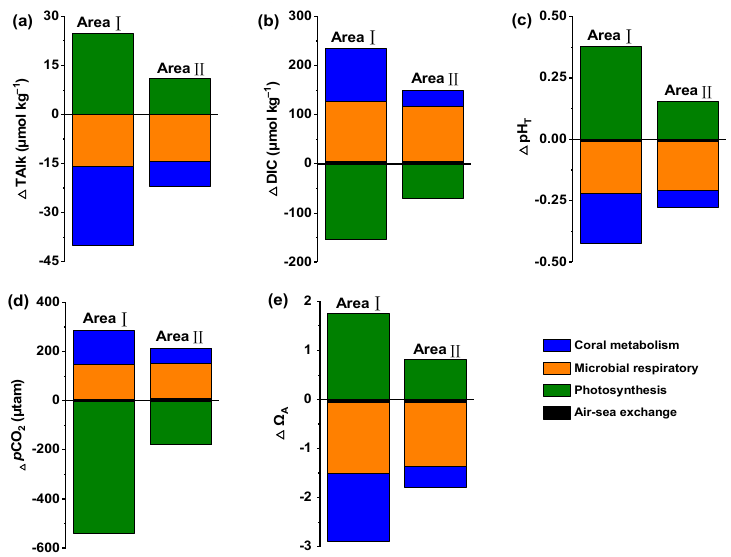
Figure A7. The correlation of carbonate parameters with Chl a ( a – d ) in the surface and bottom water of Yangmeikeng Sea Area (Area I) and Dalu Bay (Area Ⅱ ).